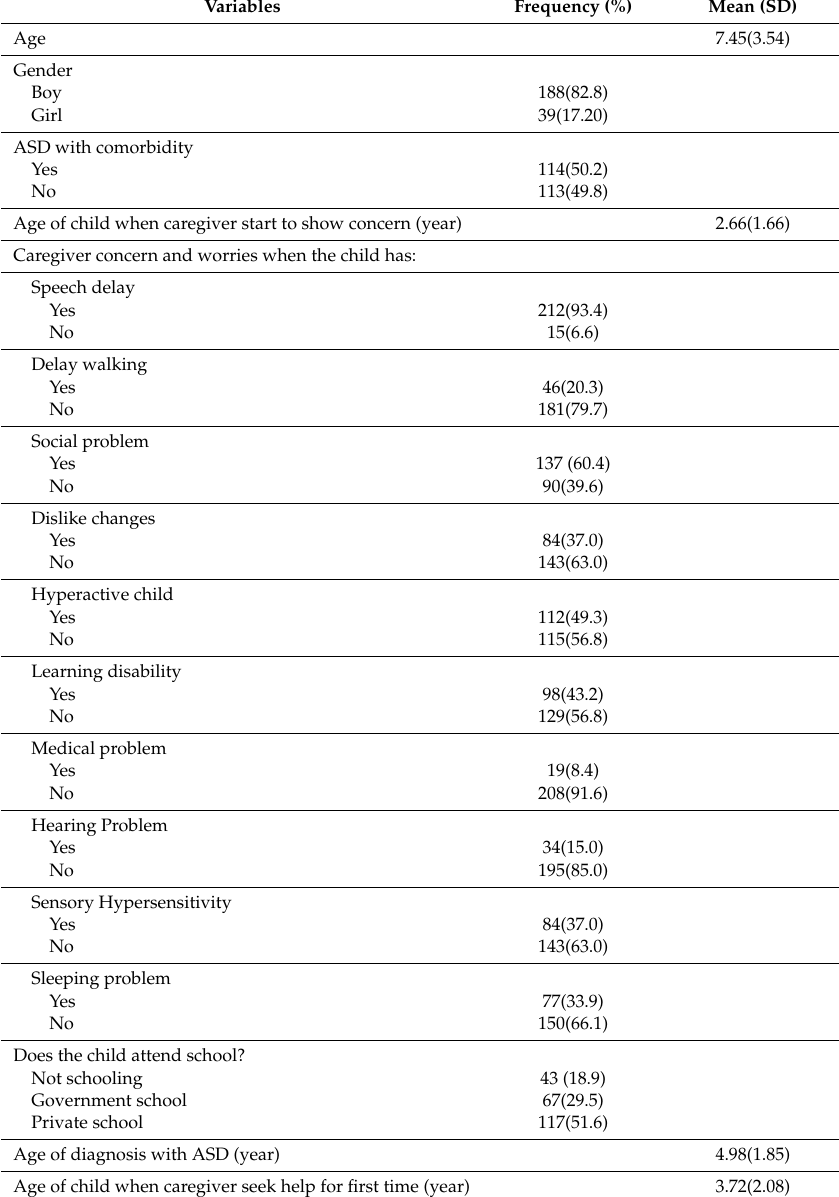
Table 2. Socio-demographic characteristics of the ASD children (n =